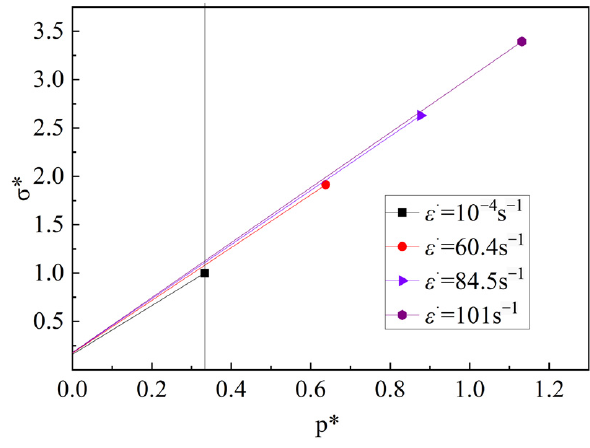
Figure 1. Technique for removing the pressure effect.